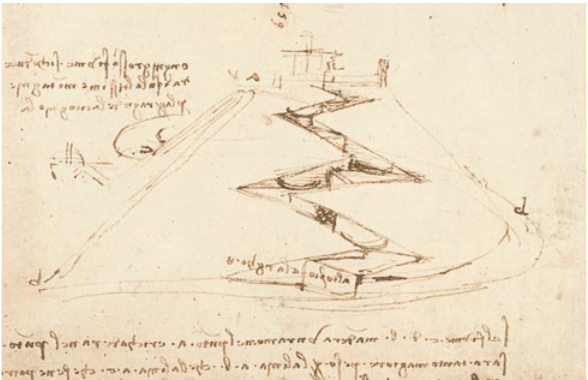
Figure 21. C.A., fol. 301 r, detail: big siphon to feed the high- est navigation basin of a system of locks to bring boats up to the mountains.